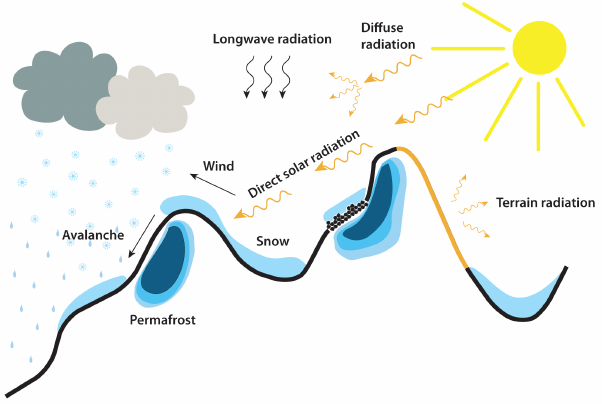
Fig. 2. Processes that influence permafrost are highly variable in mountain areas. The energy balance, shading from surrounding ter- rain and snow redistribution by wind or avalanches influence per- mafrost occurrence in high-mountain regions. The scale determines the importance of the influencing processes (Etzelm¨uller et al., 2001; Hoelzle et al., 2001).